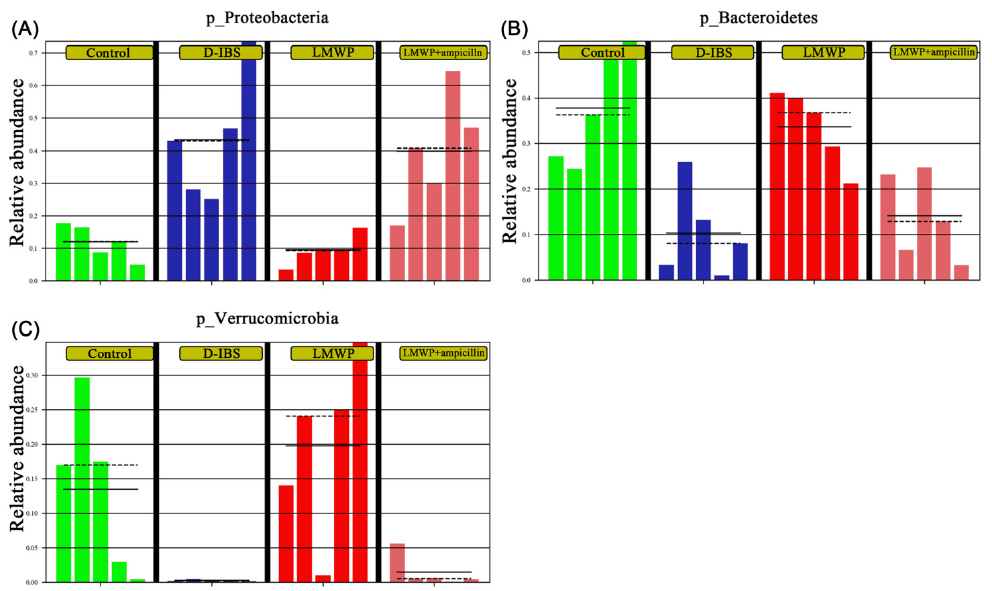
Figure 10. Relative abundances of the gut microbiota at the phylum level. ( A – C ) Relative abundances of Proteobacteria , Bacteroidetes and Verrucomicrobia .